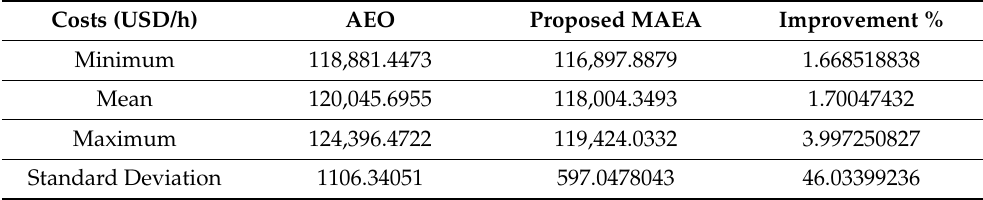
Table 7. Robustness metrics of the proposed MAEA and the basic AEA of Case 3. Table 8. Comparative Results for Case 3 for the 48-Unit System. Optimizer Best Costs (USD/h) Proposed MAEA